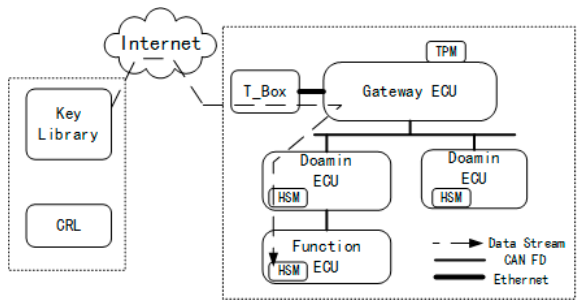
Figure 4. On-the-air (OTA)-based key update and certification revocation.